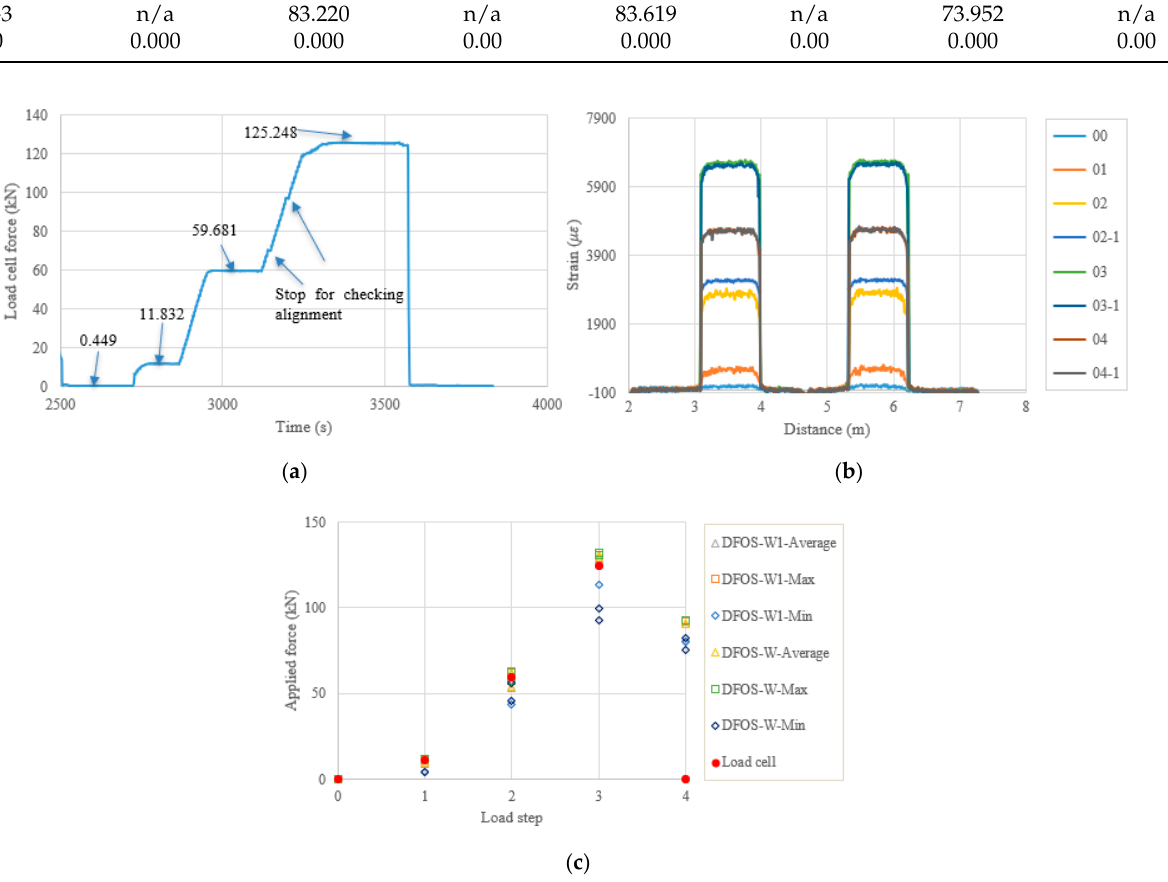
Figure 10. ( a ) Load cell readings for PC2; ( b ) strain distribution along the strand (W1 and W fibers) (In the legend, the first number represents the load step, and the second number represents measurement times at the load step); and ( c ) applied force changes at different load steps. Table 7. Prestressing force monitored by load cell and DFOSs for PC2 (unit: kN).